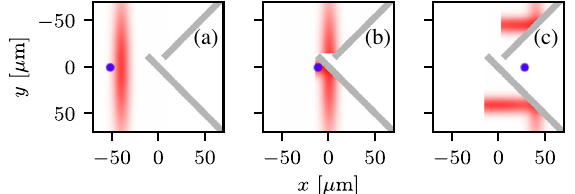
FIG. 9. Conceptual drawing for mitigating ICS energy spread increase through shaping of the reflecting surface. By deflecting as much energy as possible out of the path of the electron beam, it may be possible to reduce the collision overlap.